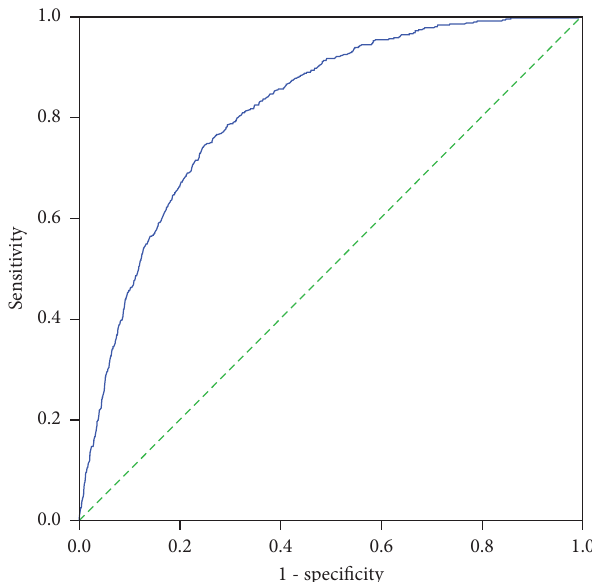
Figure 4: Te ROC curve and AUC of the nomogram for the risk of mortality. (Te blue solid line represents the nomogram-predicted probability. Te reference axis would correspond to the 45 ° green solid